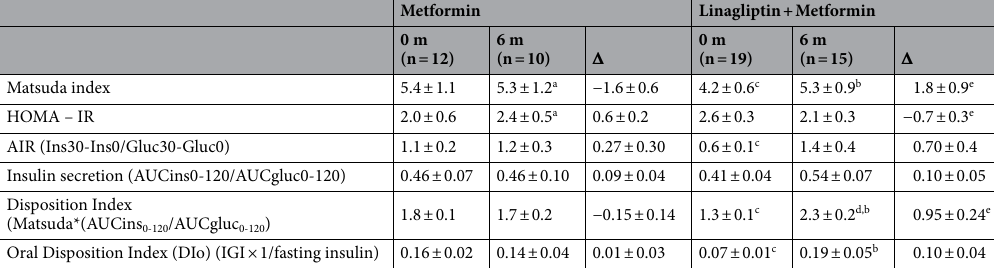
Table 2. Insulin resistance and insulin secretion at the beginning and end of the study. Data are Means ± SE. (cid:31) = change from baseline, AIR acute insulin response; AUCins0-120/AUCgluc0-120 Area under the insulin curve over the area under the glucose curve during OGTT, HOMA-IR Homeostasis Model Assessment, IGI insulinogenic index. a = p < 0.05 Metformin intragroup. b = p < 0.05 Linagliptin + Metformin intragroup. c = p < 0.05 intergroup at the beginning of the study (0 months). d = p < 0.05 intergroup at the end of the study (6 months). e = p < 0.05 Delta intergroup at 6 months of study.